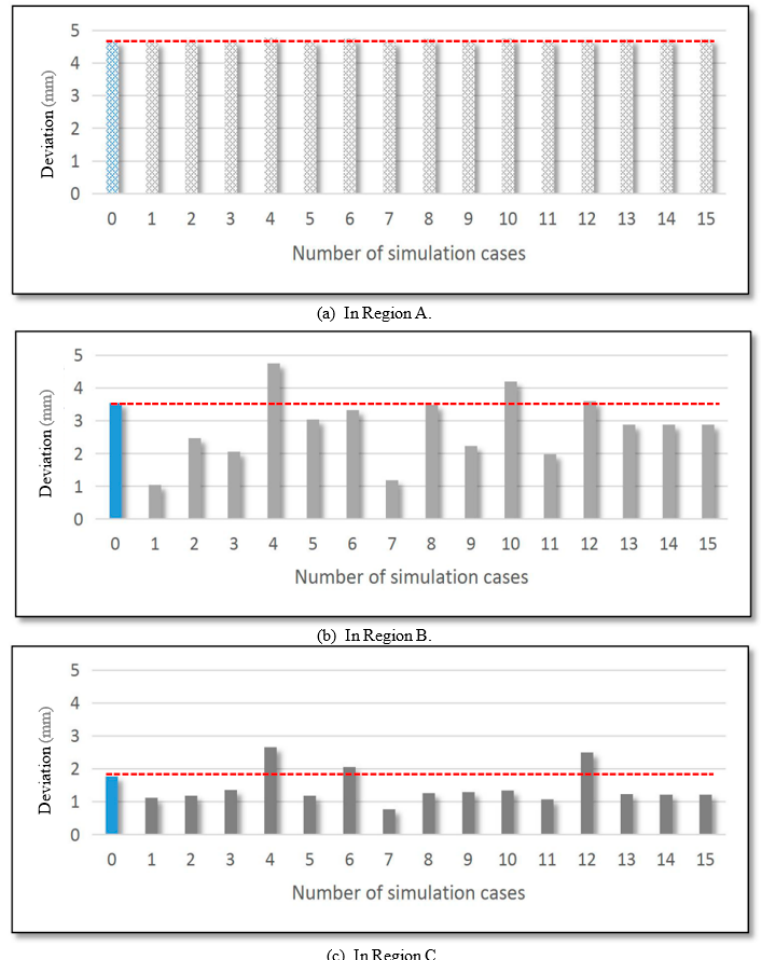
Figure 6. The maximum geometric deviation in region A, region B and region C.